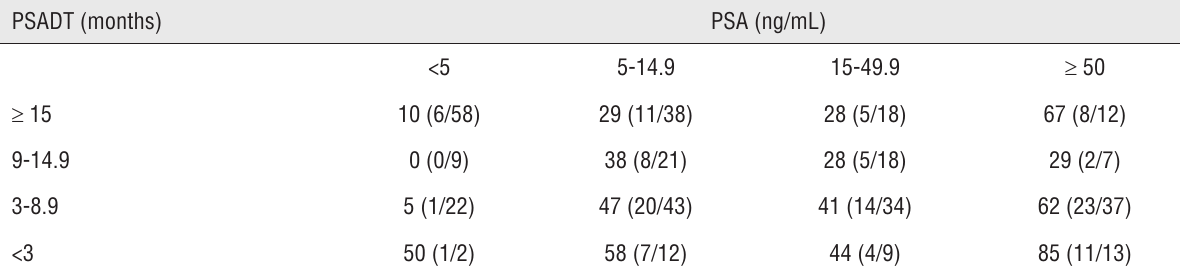
Table 5 - Predicted risk of positive scan by PSA and PSADT groups.